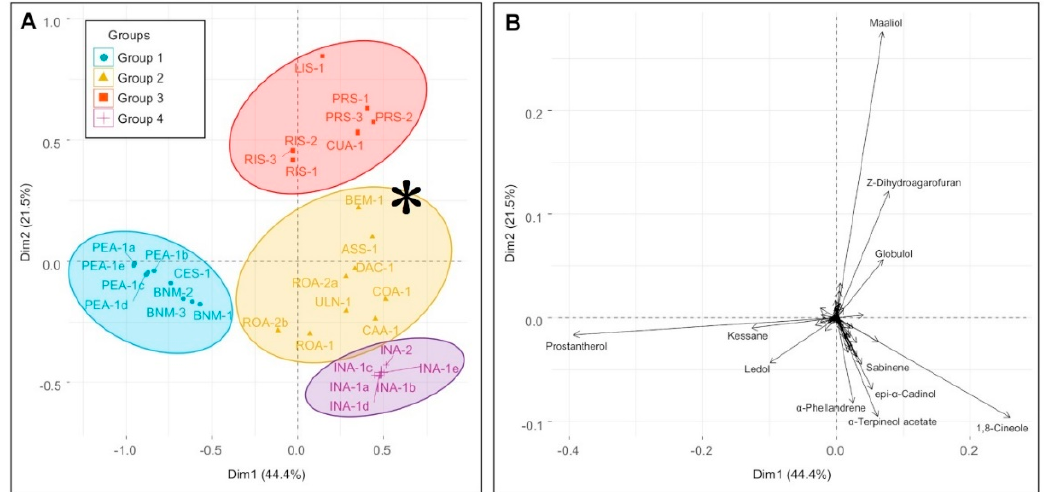
Figure 4. PCA scores plot ( A ) showing the four species most closely affiliated with P. ovalifolia , and loadings plot ( B ) showing the contribution of individual essential oil components to the segregation. LAA = P. lanceolata , CIA = P. cineolifera , OVA = P. ovalifolia (actual), and LAIA = P. latifolia .